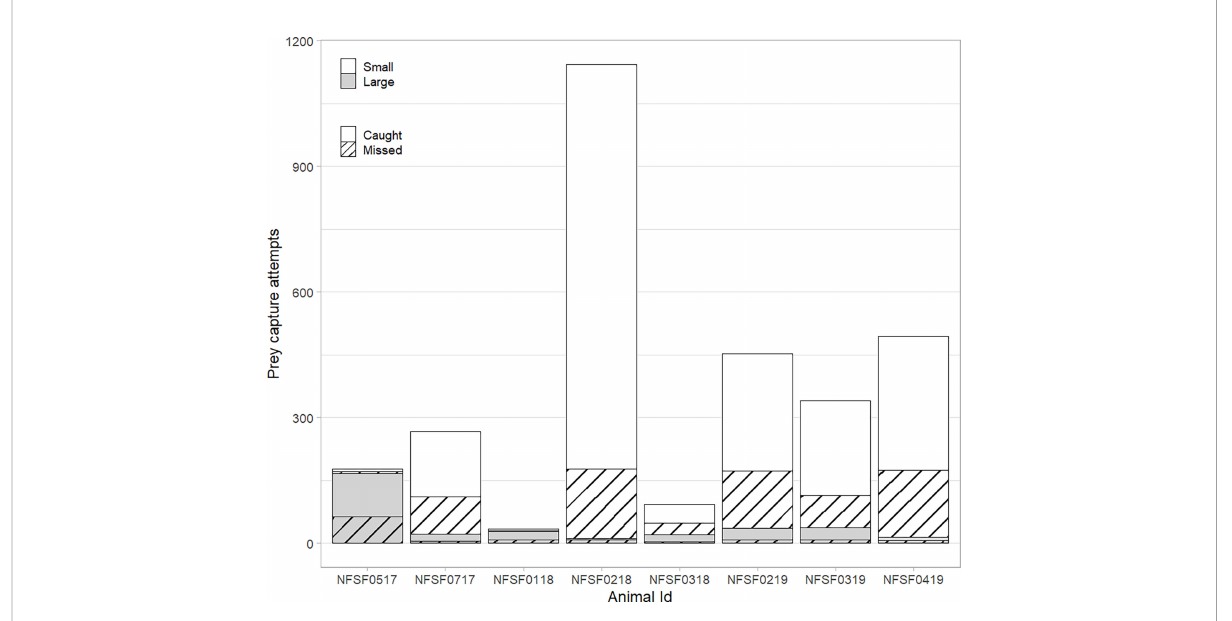
FIGURE 3 Prey capture success (caught= solid, missed= hatched) for eight northern fur seals by relative prey size (white= small, grey= large). Differences in total prey capture are primarily related to the duration of video recording (Table